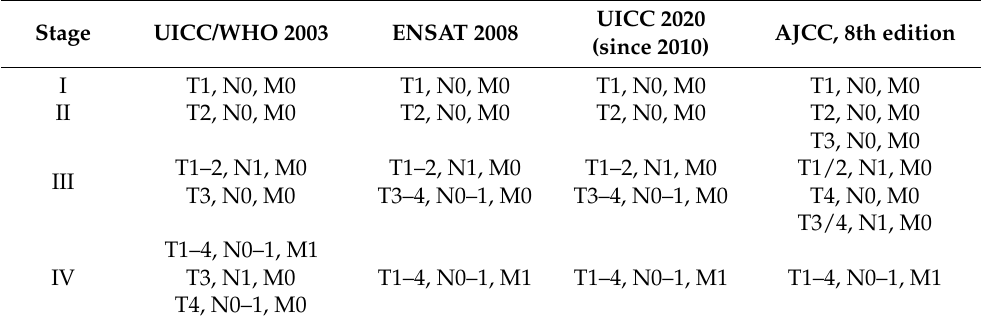
Table 4. Changes in TNM classification over